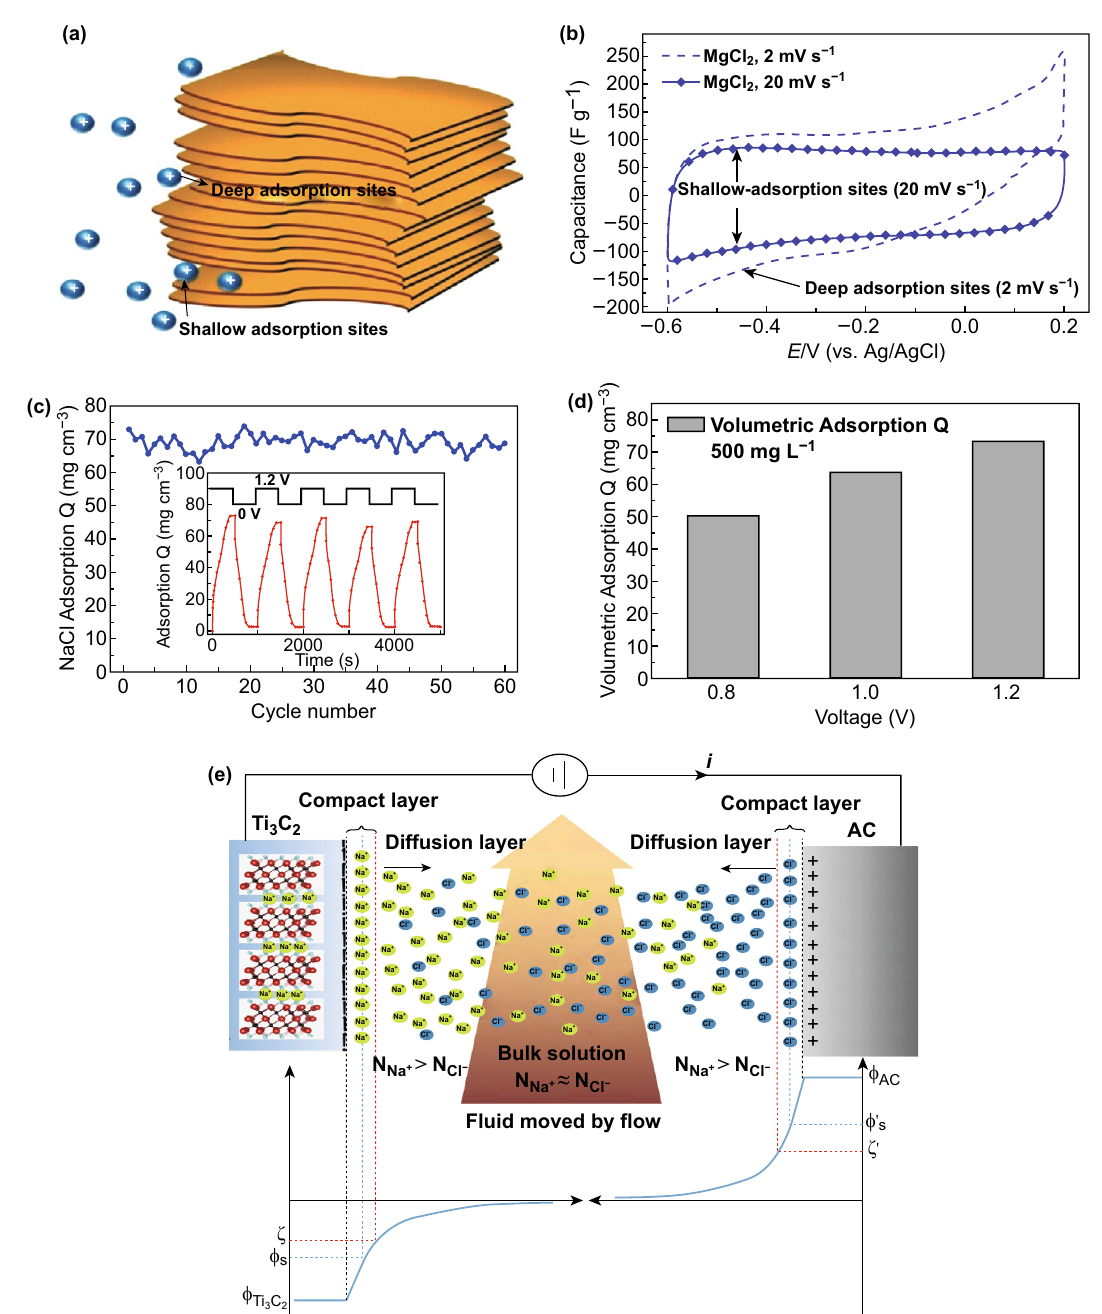
Fig. 11 a Schematic illustration of multilayered Ti 3 C 2 T x particle containing shallow and deep adsorption sites near the gap opening and in its interior, respectively, b Capacitance of Ti 3 C 2 T x /carbon black–PTFE laminate in a Swagelok cell measured at scan rates of 2 and 20 mV s −1 (dash line and symbols, respectively) in 1 M MgCl 2 related to deep and shallow adsorption sites, respectively. Reprinted with permission from Ref. [66]. Copyright © (2015) John Wiley & Sons, Inc. c Electroadsorption and regeneration cycles of porous Ti 3 C 2 T x electrode in 500 mg L −1 NaCl solution. d Electroadsorption capacitance of porous Ti 3 C 2 T x at varied voltage in 500 mg L −1 NaCl solution. Reprinted with permission from Ref. [62]. Copyright © (2018) Elsevier Inc. e Schematics of the CDI process. Reprinted with permission from Ref. [60]. Copyright © (2018) Elsevier